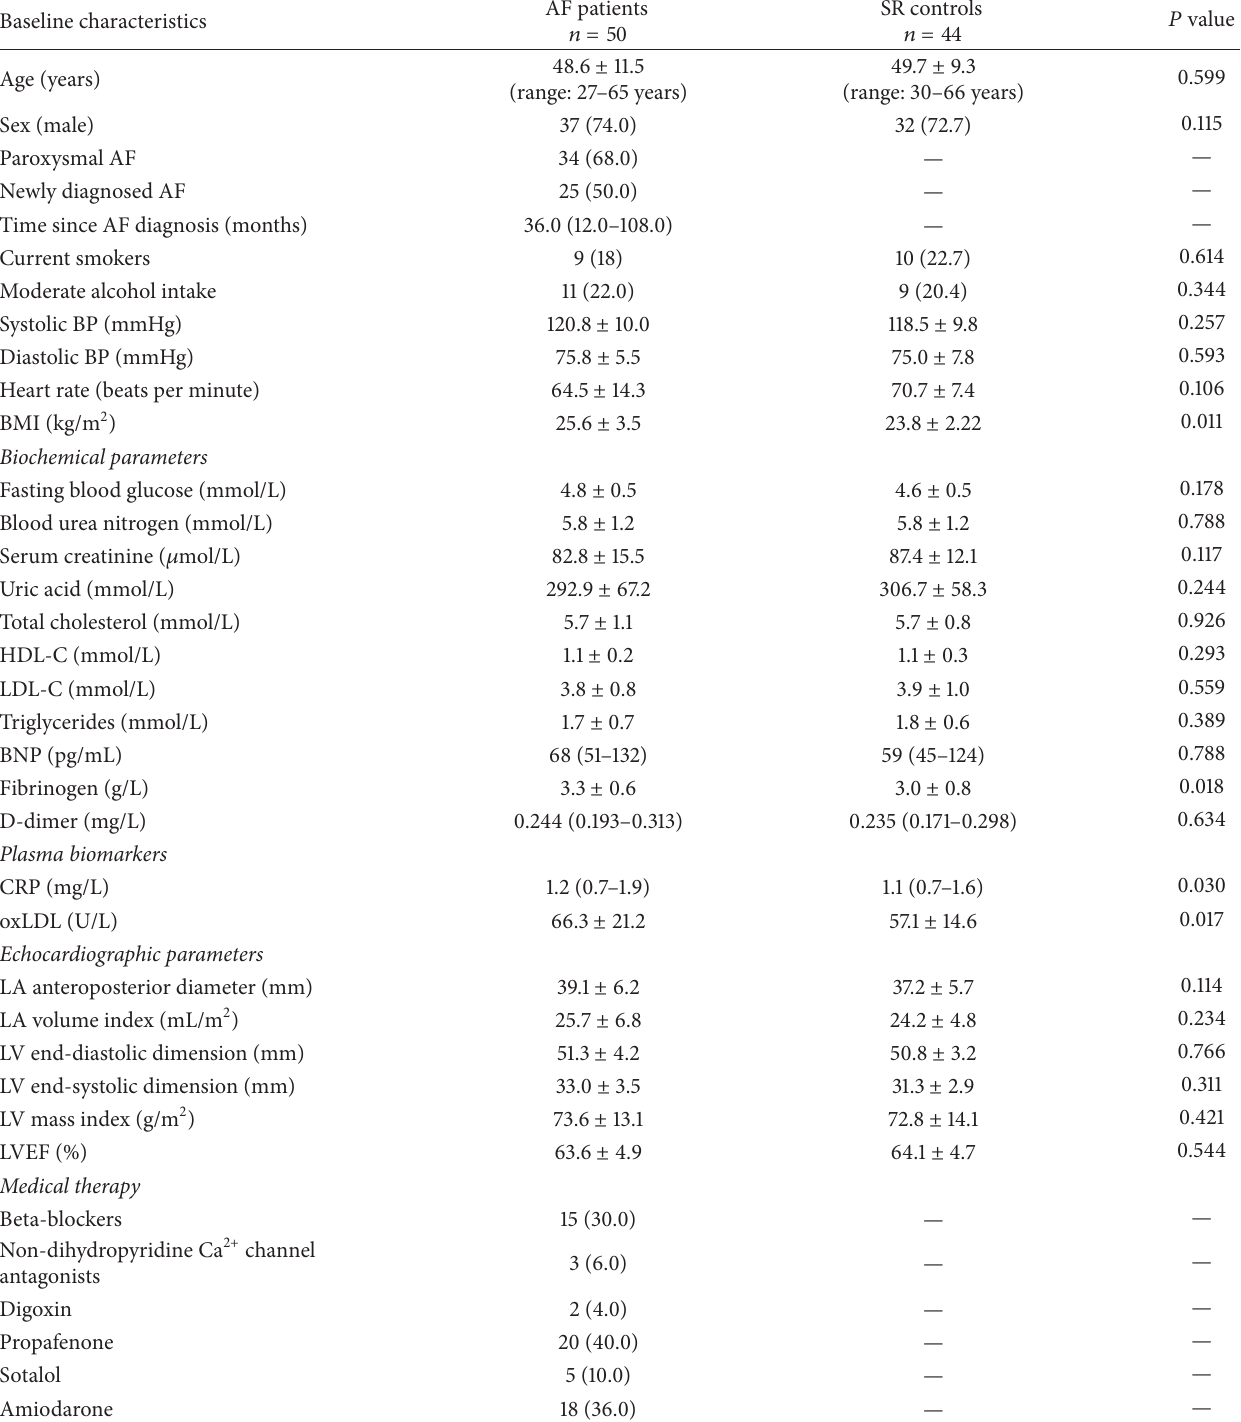
Table 1: Baseline characteristics of lone AF patients and healthy